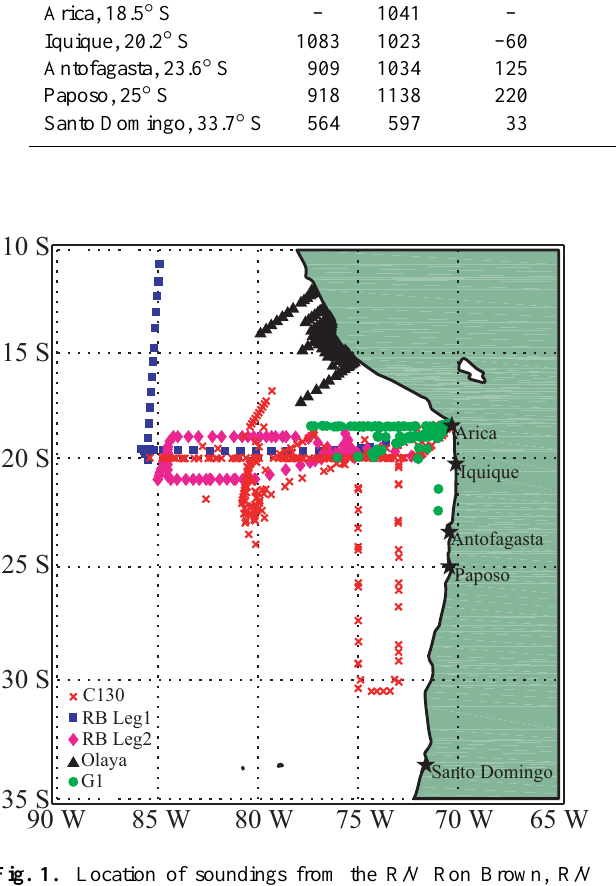
Fig. 1. Location of soundings from the R/V Ron Brown, R/V Jos´e Olaya, and land-based launch sites during VOCALS-REx (October–November 2008). C130 and G1 airborne observations in- dicate where the aircraft passed through the top of the MBL.